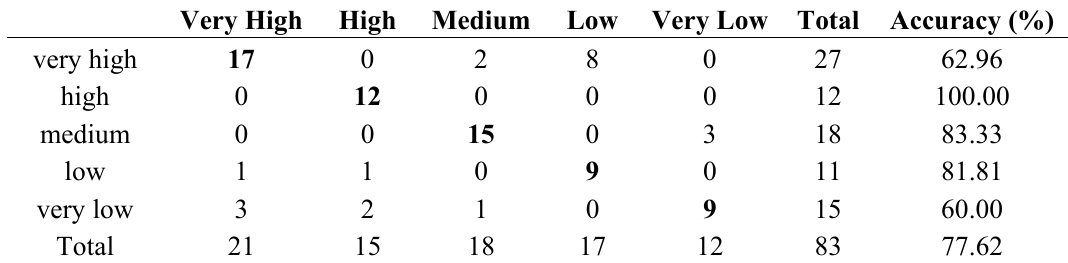
Table 5. Confusion matrix in the Vea study area.